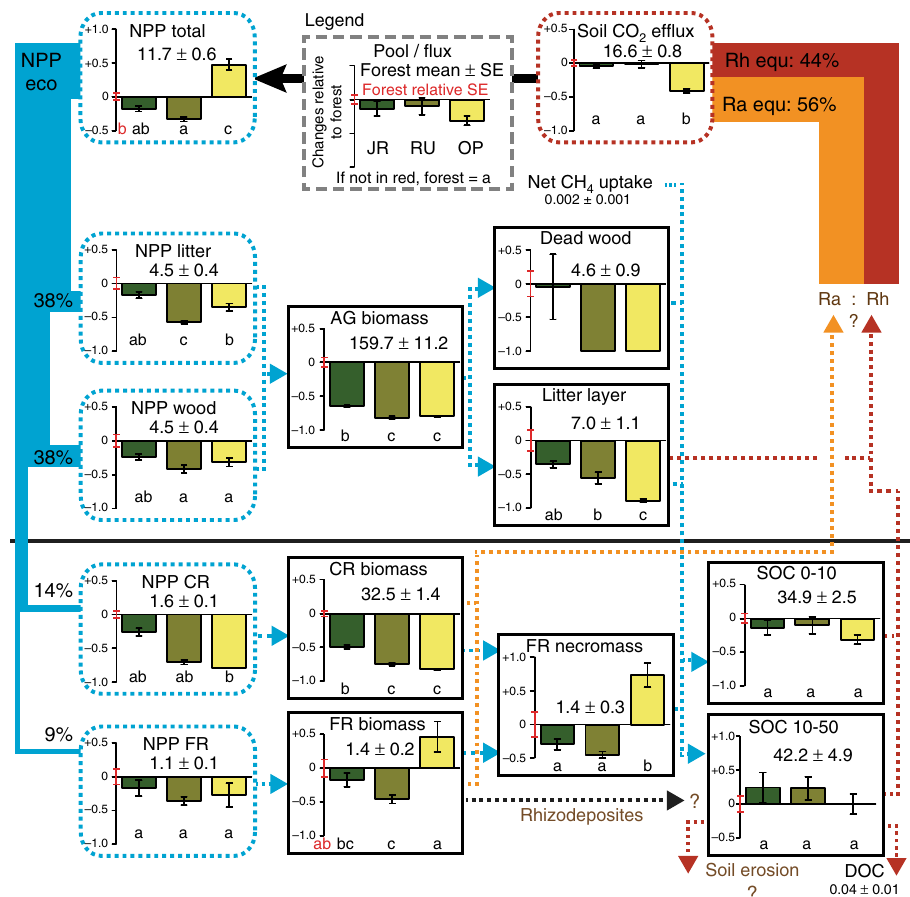
Fig. 2 Effects of land-use change on ecosystem carbon pools and fl uxes. Relative changes in plantations were calculated as (plantation value/forest mean) − 1. Zero indicates no change compared to rainforest and − 1, a decrease of 100%. Legends of individual fi gures are explained in the top central fi gure, where JR is jungle rubber, RU is rubber monoculture, and OP is oil palm plantation. Abbreviations correspond to net primary production (NPP), coarse roots (CR), fi ne roots (FR), aboveground (AG), soil organic carbon (SOC), dissolved organic carbon (DOC), contribution of autotrophic respiration (Ra equ), and heterotrophic respiration (Rh equ) in rainforest assuming the ecosystem to be at equilibrium. Dashed arrows indicate fl uxes of C within the ecosystems. Fluxes in brown followed by a question mark represent the main knowledge gaps related to the C cycle. Means ± SE of forest pools and fl uxes are given